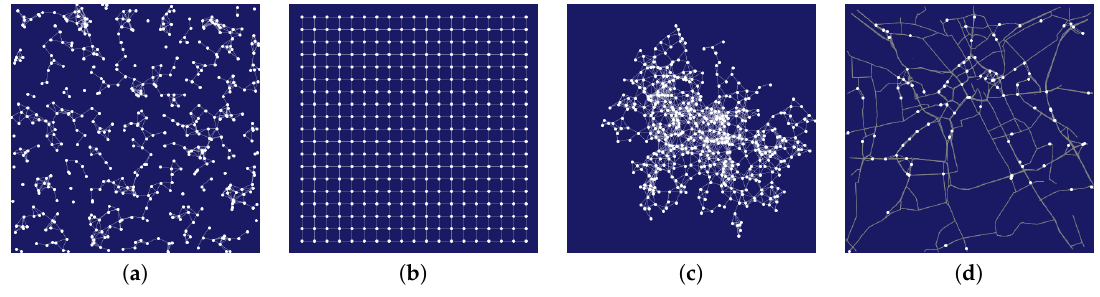
Figure 3. Deployment strategies. ( a ) Completely random deployment; ( b ) grid deployment; ( c ) diffusion deployment around a central node; ( d ) vehicular ad hoc network